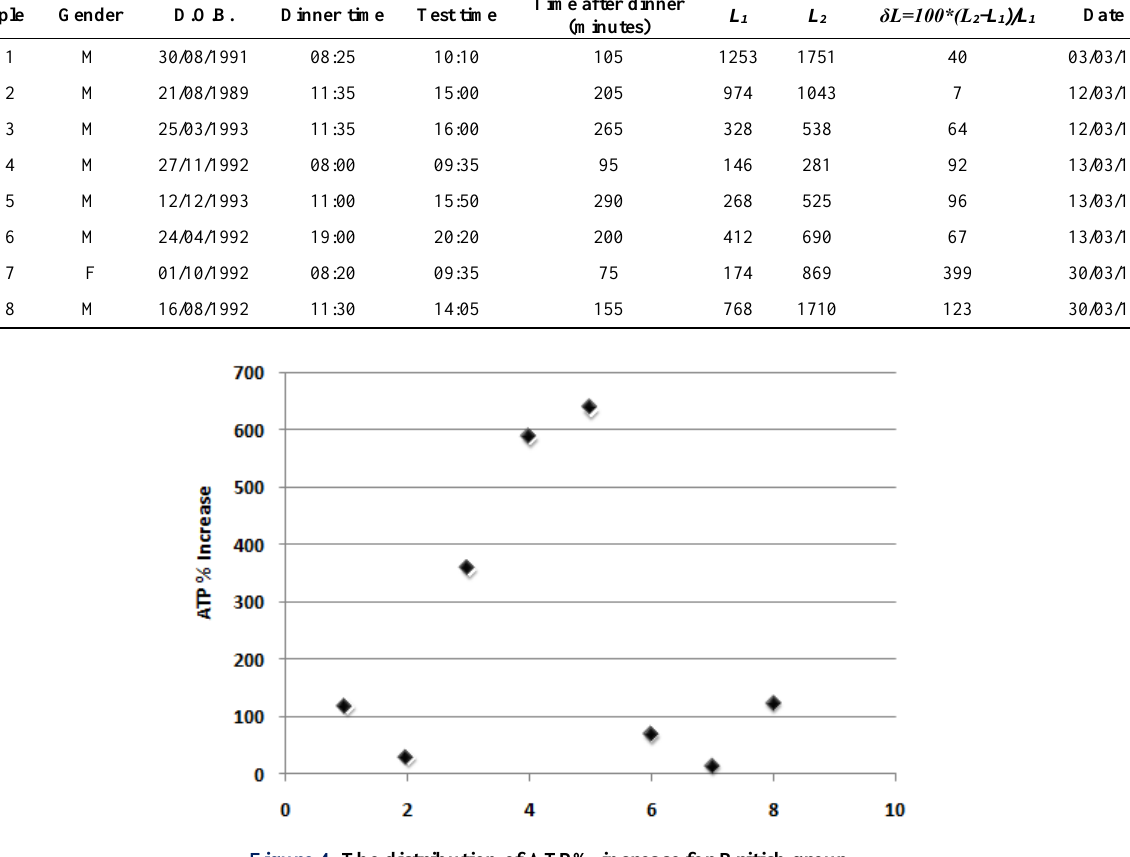
Figure 4. The distribution of ATP% increase for British group.